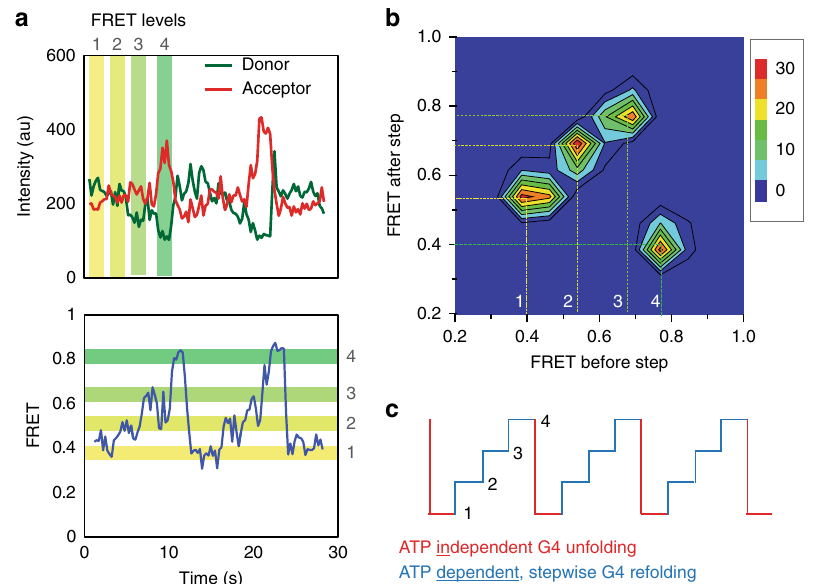
Fig. 3 G4-RNA refolding entails discrete steps of DHX36 movement. a smFRET trace that shows anticorrelated change of donor (Cy3, green) and acceptor (Cy5, red) (top). FRET traces calculated from donor and acceptor intensity (bottom). b Transition density plot generated by taking FRET values before and after FRET transition for the successive FRET steps. c Schematic representation of FRET steps. One step FRET decrease corresponds to ATP independent G4 unfolding (red) while stepwise FRET increase indicates ATP dependent multistep refolding of G4